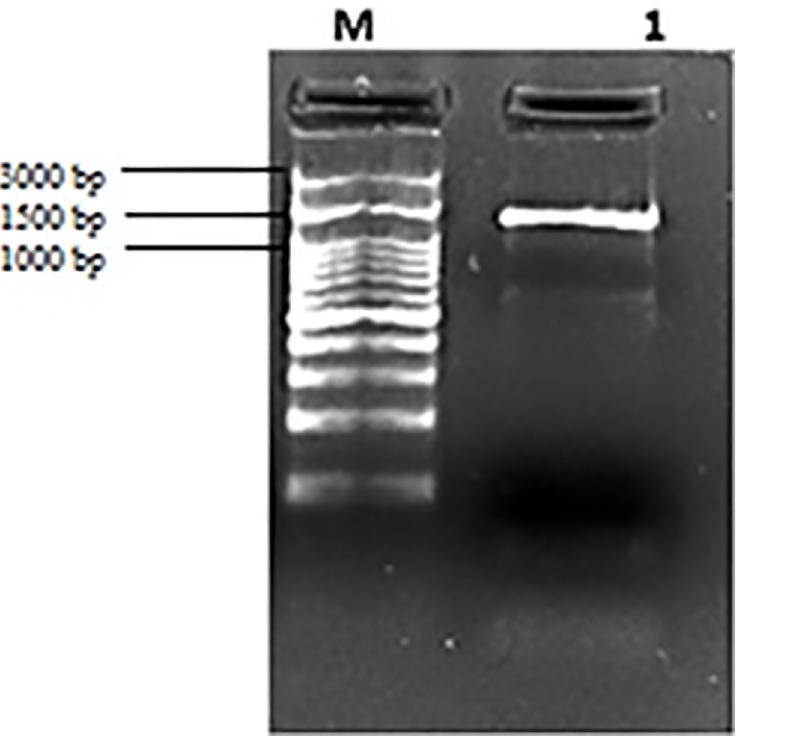
Fig 2. Electrophoresis of single band of 16S rDNA PCR, M: Marker.